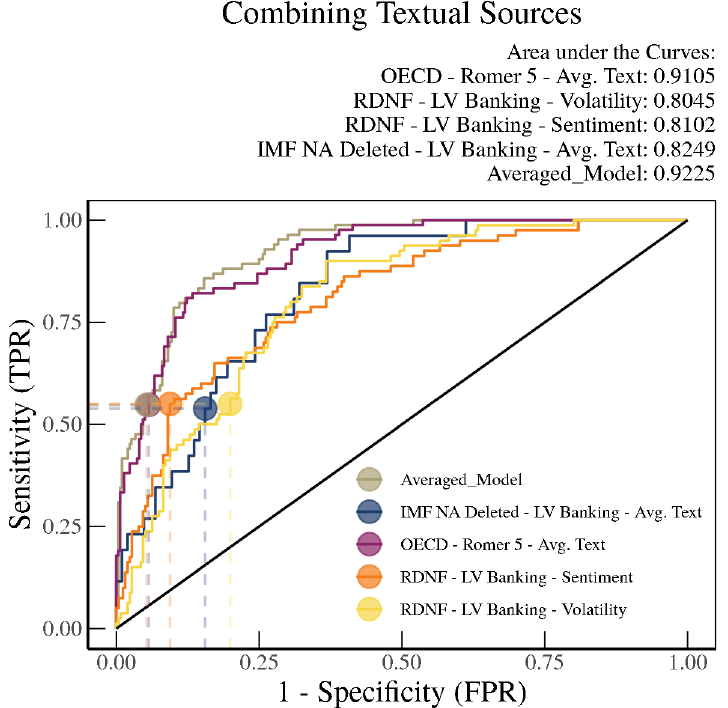
Figure 17. Results for Combined Model . Note: This figure shows the ROC curves for our out-of- sample period (post-2005). We introduce a combination model by combining the model outputs of the models that work well: the Average Text Model predicting moderate crises according to Romer and Romer (2017) using OECD Economic Outlook text, the Volatility and Sentiment Models predicting banking crises according to Laeven and Valencia (2013) using RDNF text, and the Average Text Model predicting banking crises using IMF Article IV text. The figure shows that averaging the model predictions of these four models (referred to as the “Averaged Model” in the figure) boosts the area under the curve (AUC) to 0.9225. All models were trained on pre-2005